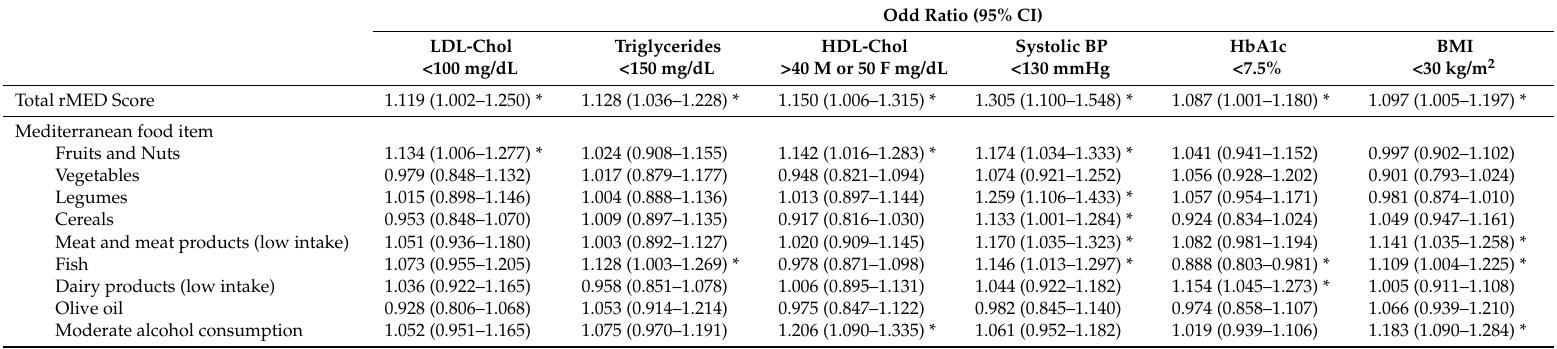
Table 5. Odds ratio (95% CI) for the achievement of treatment target for LDL cholesterol, triglycerides, HDL-cholesterol, systolic blood pressure, BMI, and HbA1c associated to one-point increase of the total rMED score and of the score for each food item component of the